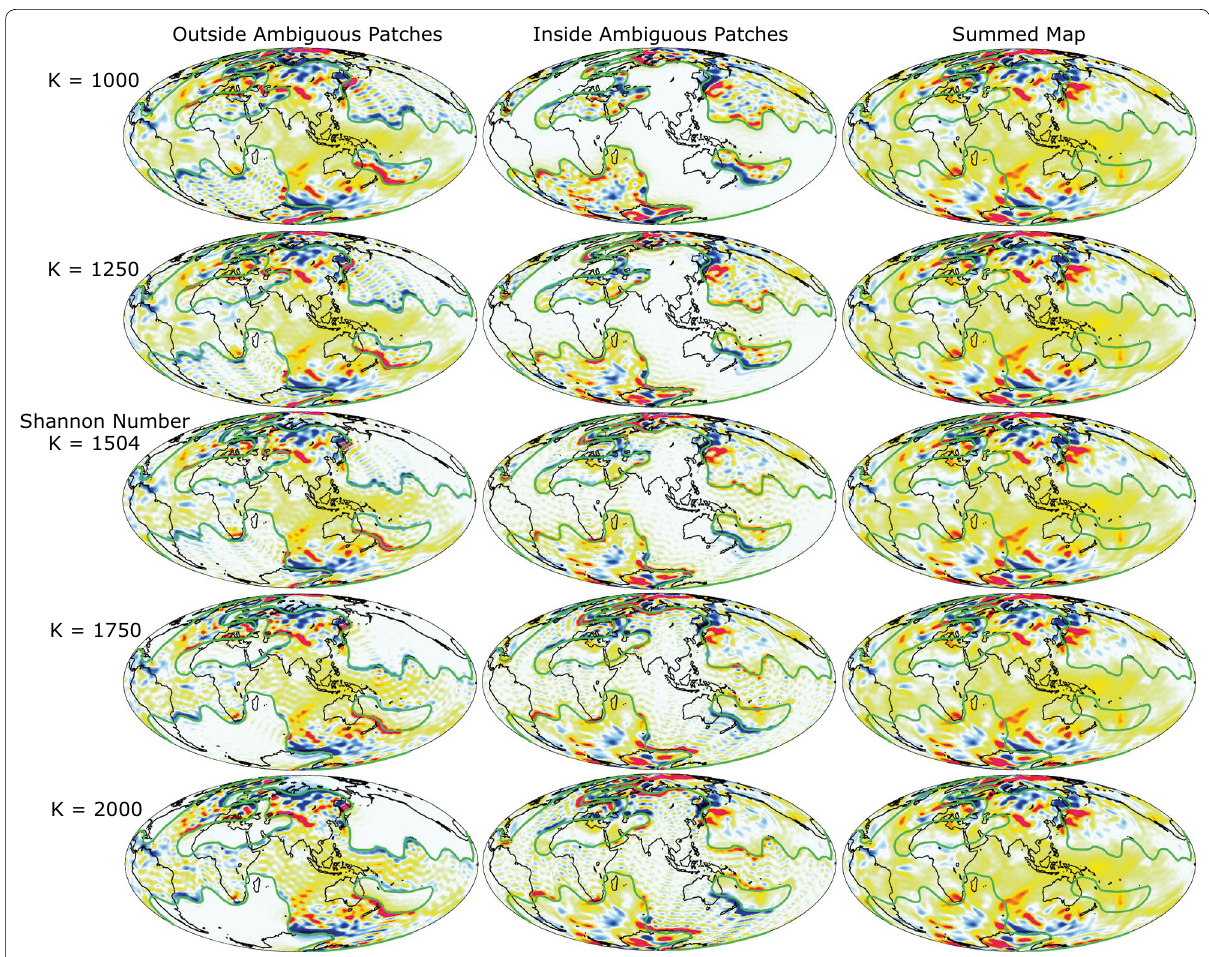
Fig. 6 Varying K number of functions representing ‘inside’ the patches for the numerical dynamo flow simulation decomposition. Decomposition of the numerical dynamo model snapshot into ‘inside’ and ‘outside’ patch. The K value is the number of functions included inside the patches and 3721 1 ) is the number of functions outside the patches. The φ -component of the toroidal flow is ( K − +